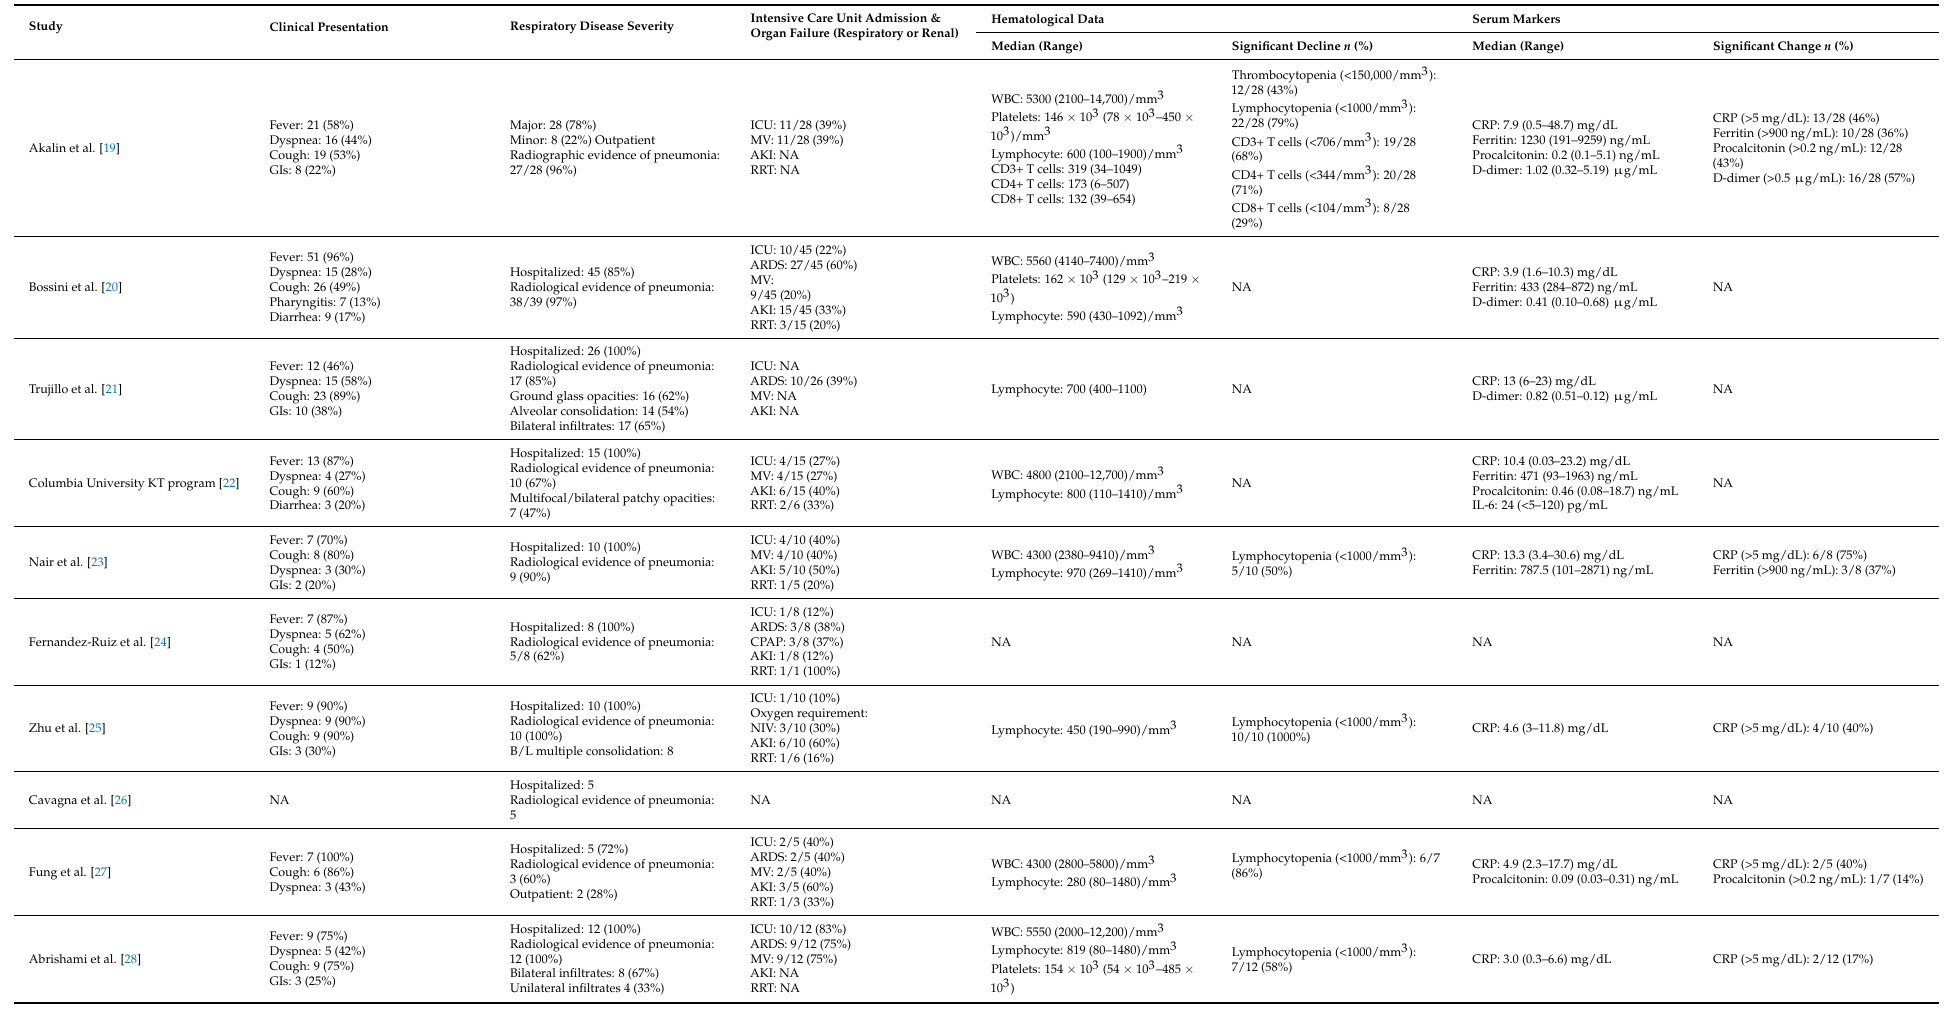
Table A2. Clinical and laboratory data of post-kidney transplant patients with